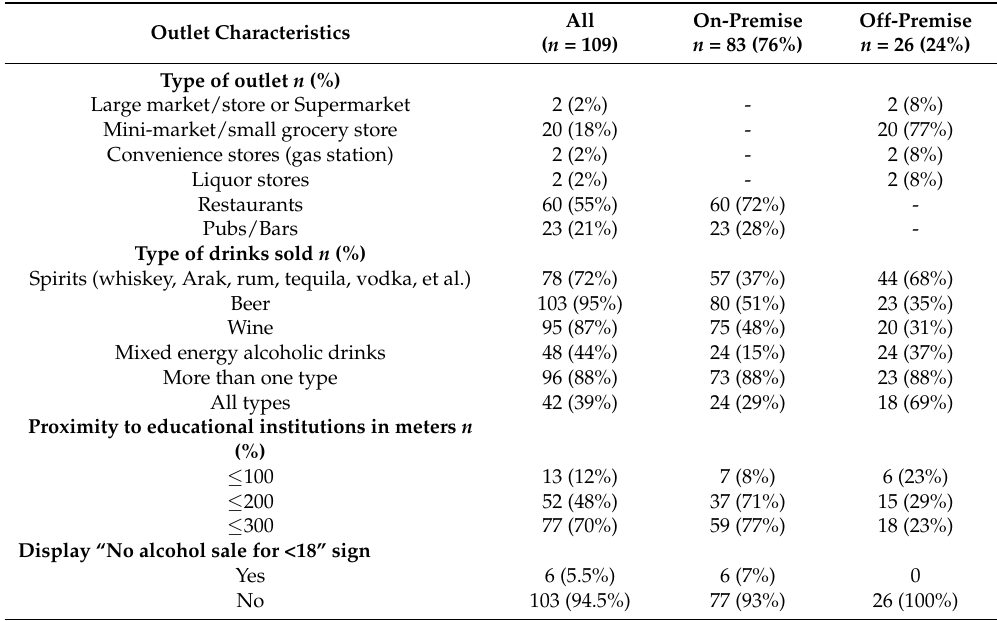
Table 1. Characteristics of the surveyed on-premise and off-premise alcohol outlets in the four neighborhoods of Beirut district.